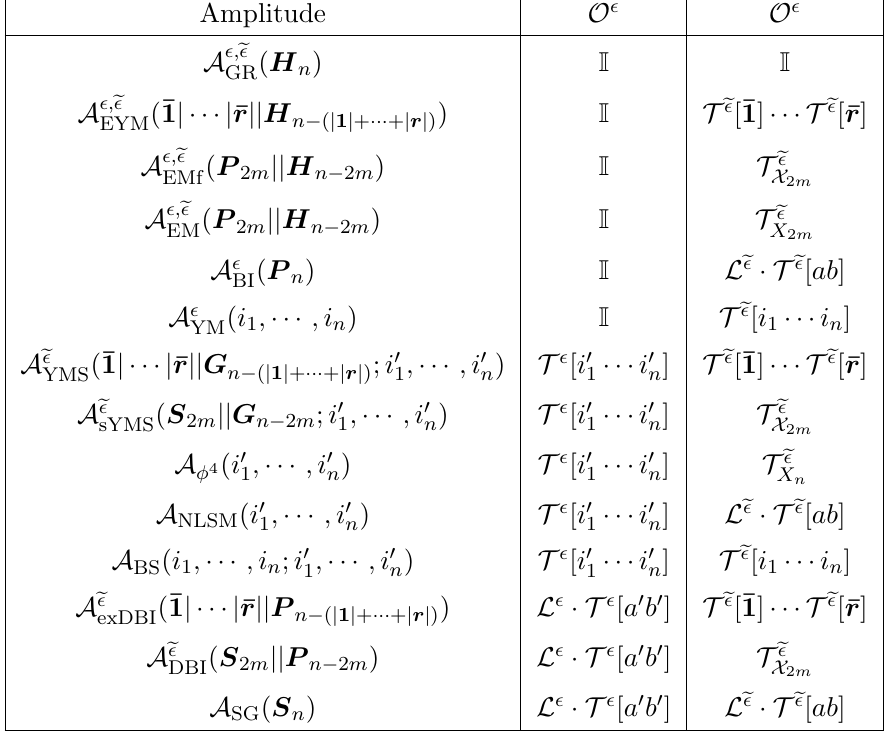
Table 1 . Unifying relations for di(cid:11)erential